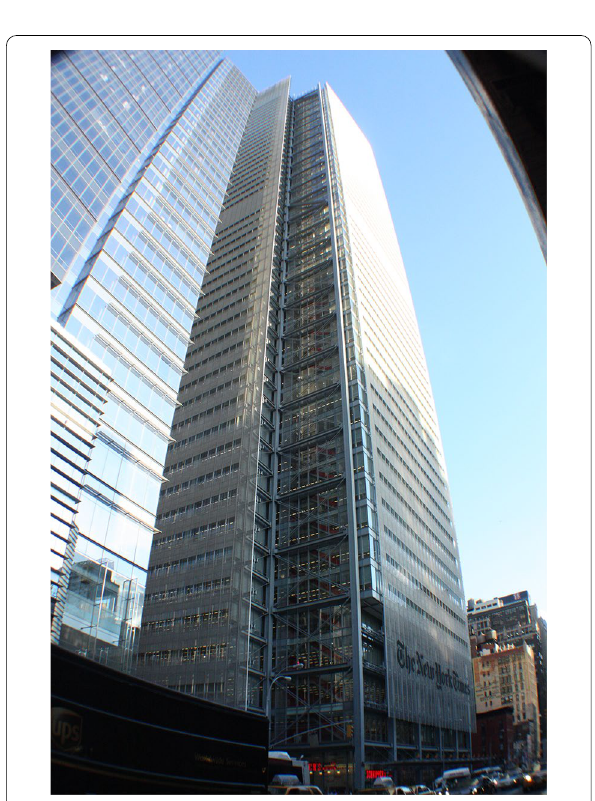
Fig. 11 The New York Times Tower is a pure